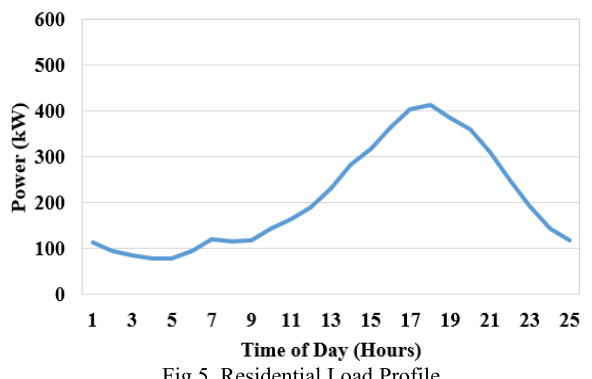
Fig.5. Residential Load Profile